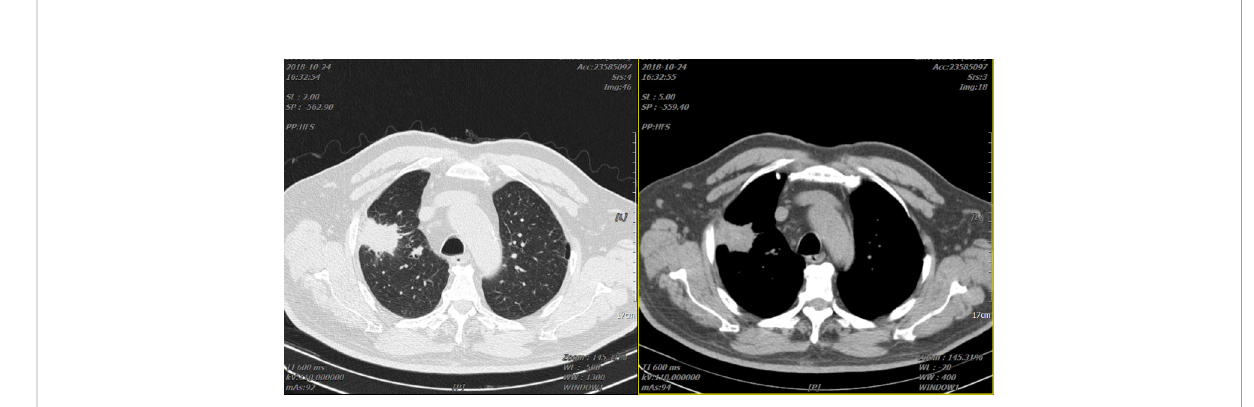
FIGURE 1 Two representative CTs of the patient on 24 October